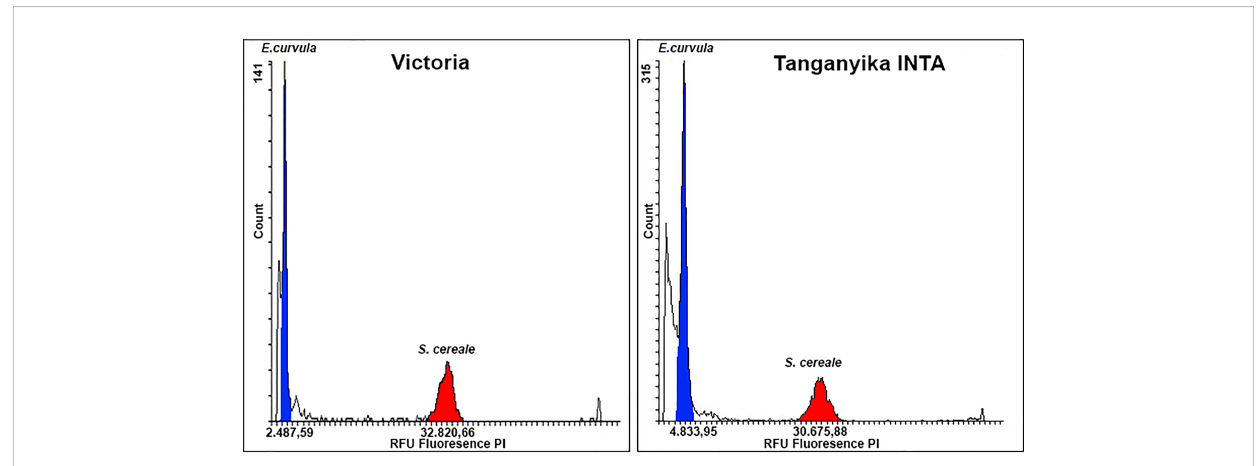
FIGURE 2 Flow cytometry histogram to assess E. curvula genome size. Y-axis shows nuclei count, while Y-axis display propidium iodide (PI) fl uorescence. E. curvula and S. cereale are highlighted in blue and red, respectively. Victoria genotype presented half of the Tanganyika INTA RFU obtaining a genome length of 604.3 and 1,247.5 Mb,